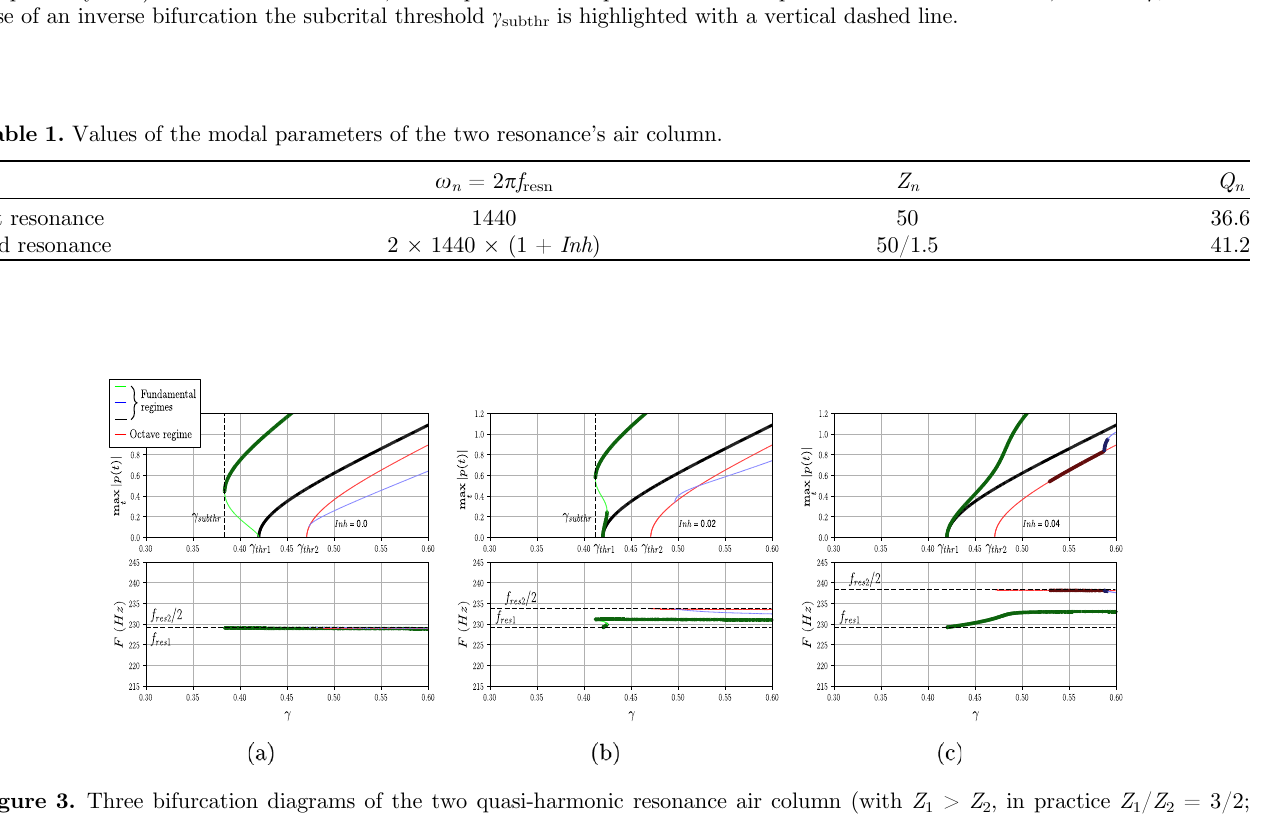
Figure 3. Three bifurcation diagrams of the two quasi-harmonic resonance air column (with Z 1 > Z 2 , in practice Z 1 / Z 2 = 3/2; parameters values in Tab. 1) with respect to the control parameter c . From top to bottom: Inh = 0 (a), Inh = 0.02 (b) and Inh = 0.04 (c). Each case is described with two plots. Upper plot: Maximum of the absolute value of the periodic solution with respect to c . The branch in green (respectively in red, and in blue) corresponds to the fundamental regime, the standard Helmholtz motion (respectively the octave regime, and the inverted Helmholtz motion fundamental regime). Note that a black curve corresponding to a direct Hopf bifurcation is branched at c = c thr1 . This fundamental regime corresponds to an air column having only one resonance at the frequency f res1 . Lower plot: Frequency with respect to c . The frequency branch in green (respectively in red) corresponds to the fundamental frequency of the fundamental regime (respectively the octave regime, frequency divided by 2). The reference dashed horizontal lines are the reference frequencies: f res1 and f res2